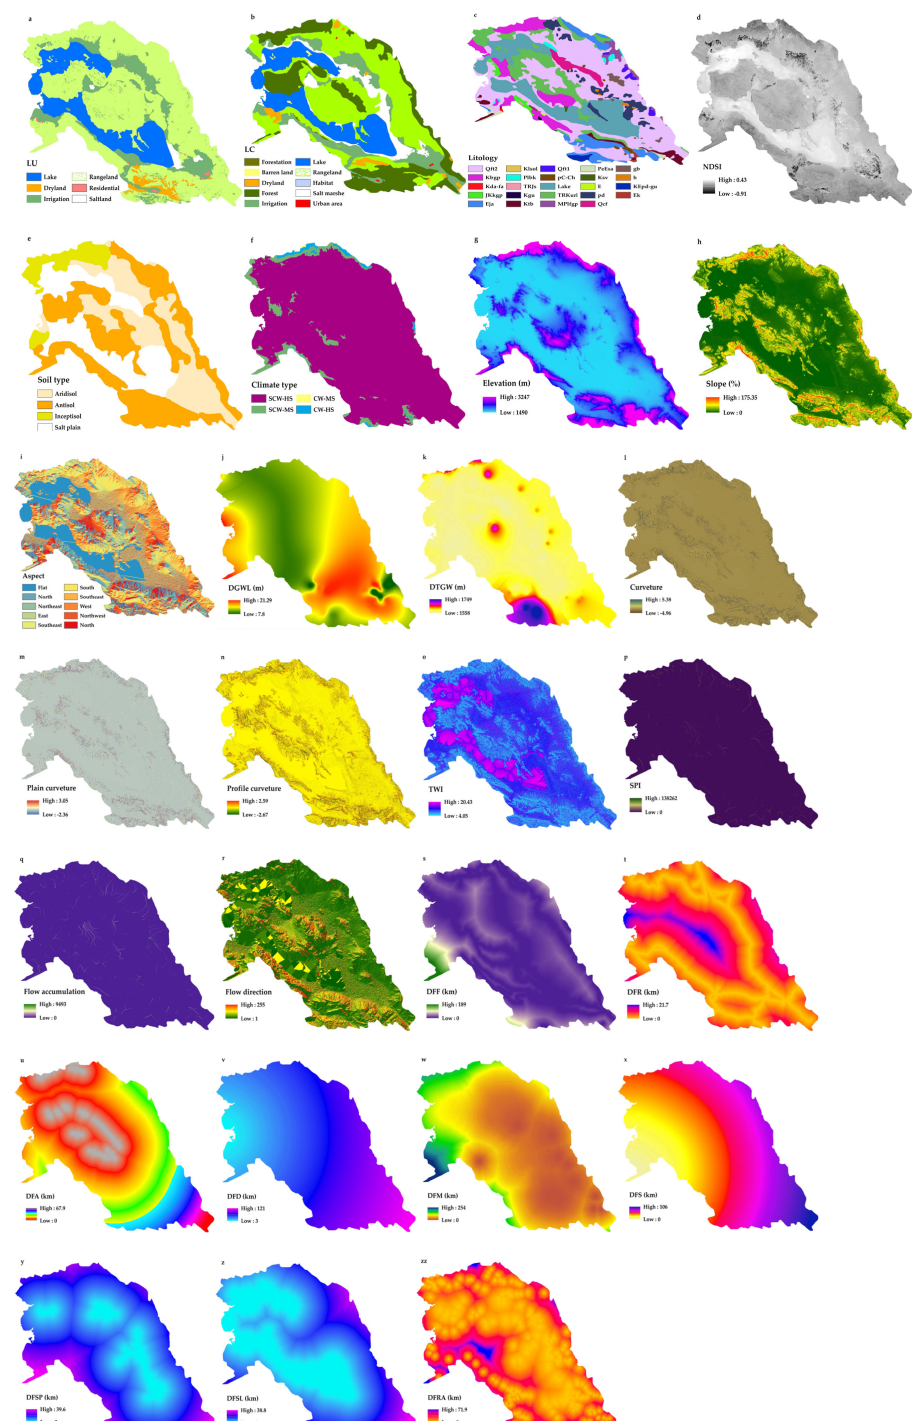
Figure 3. Subsidence predictor variables: ( a ) land use (LU), ( b ) land cover (LC), ( c ) lithology, ( d ) normalized difference salinity index (NDSI), ( e ) soil type, ( f ) climate type, ( g ) elevation, ( h ) slope, ( i ) aspect, ( j ) decline in groundwater level (DGWL), ( k ) depth of groundwater (DTGW), ( l ) curvature, ( m ) plain curvature, ( n ) profit curvature, ( o ) Topographic Wetness Index (TWI), ( p ) stream power index (SPI), ( q ) flow accumulation, ( r ) flow direction, ( s ) distance from faults (DFF), ( t ) distance from roads (DFR), ( u ) distance from an anticline (DFA), ( v ) distance from dams (DFD), ( w ) distance from mines (DFM), ( x ) distance from syncline (DFS), ( y ) distance from salt plain (DFSP), ( z ) distance from salt lake (DFSL), ( zz ) distance from residential areas